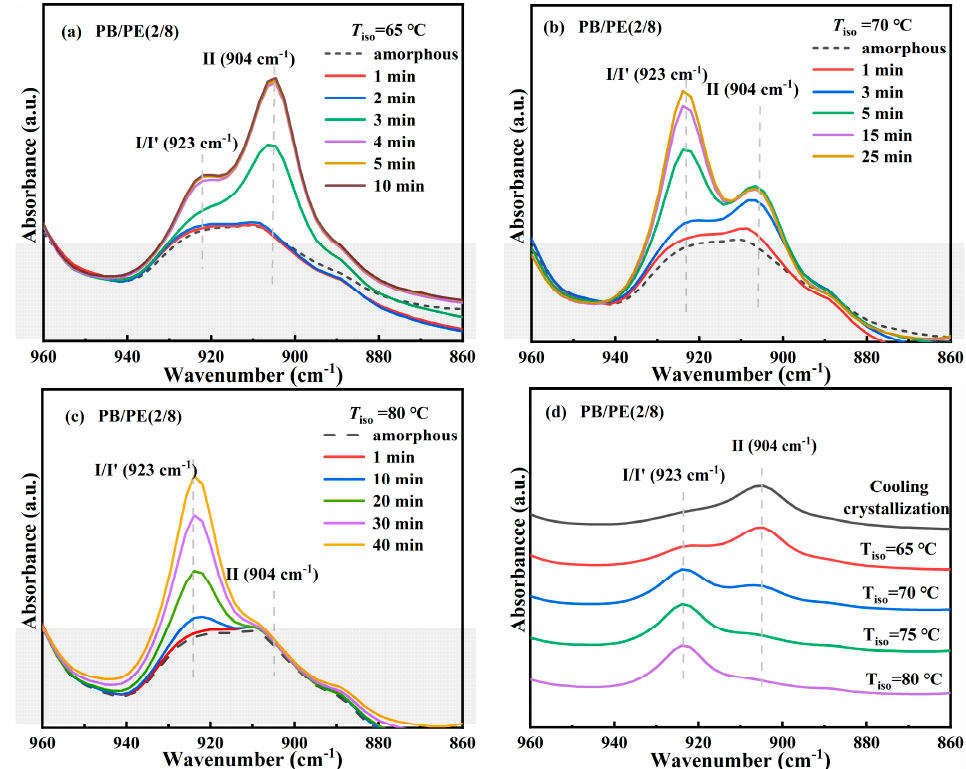
Figure 5. In situ FTIR spectra of PB/PE(2/8) obtained during isothermal crystallizations at ( a ) 65, ( b ) 70, and ( c ) 80 °C. ( d ) The summarized FITR spectra of PB/PE(2/8) after isothermal crystallization at different temperatures.